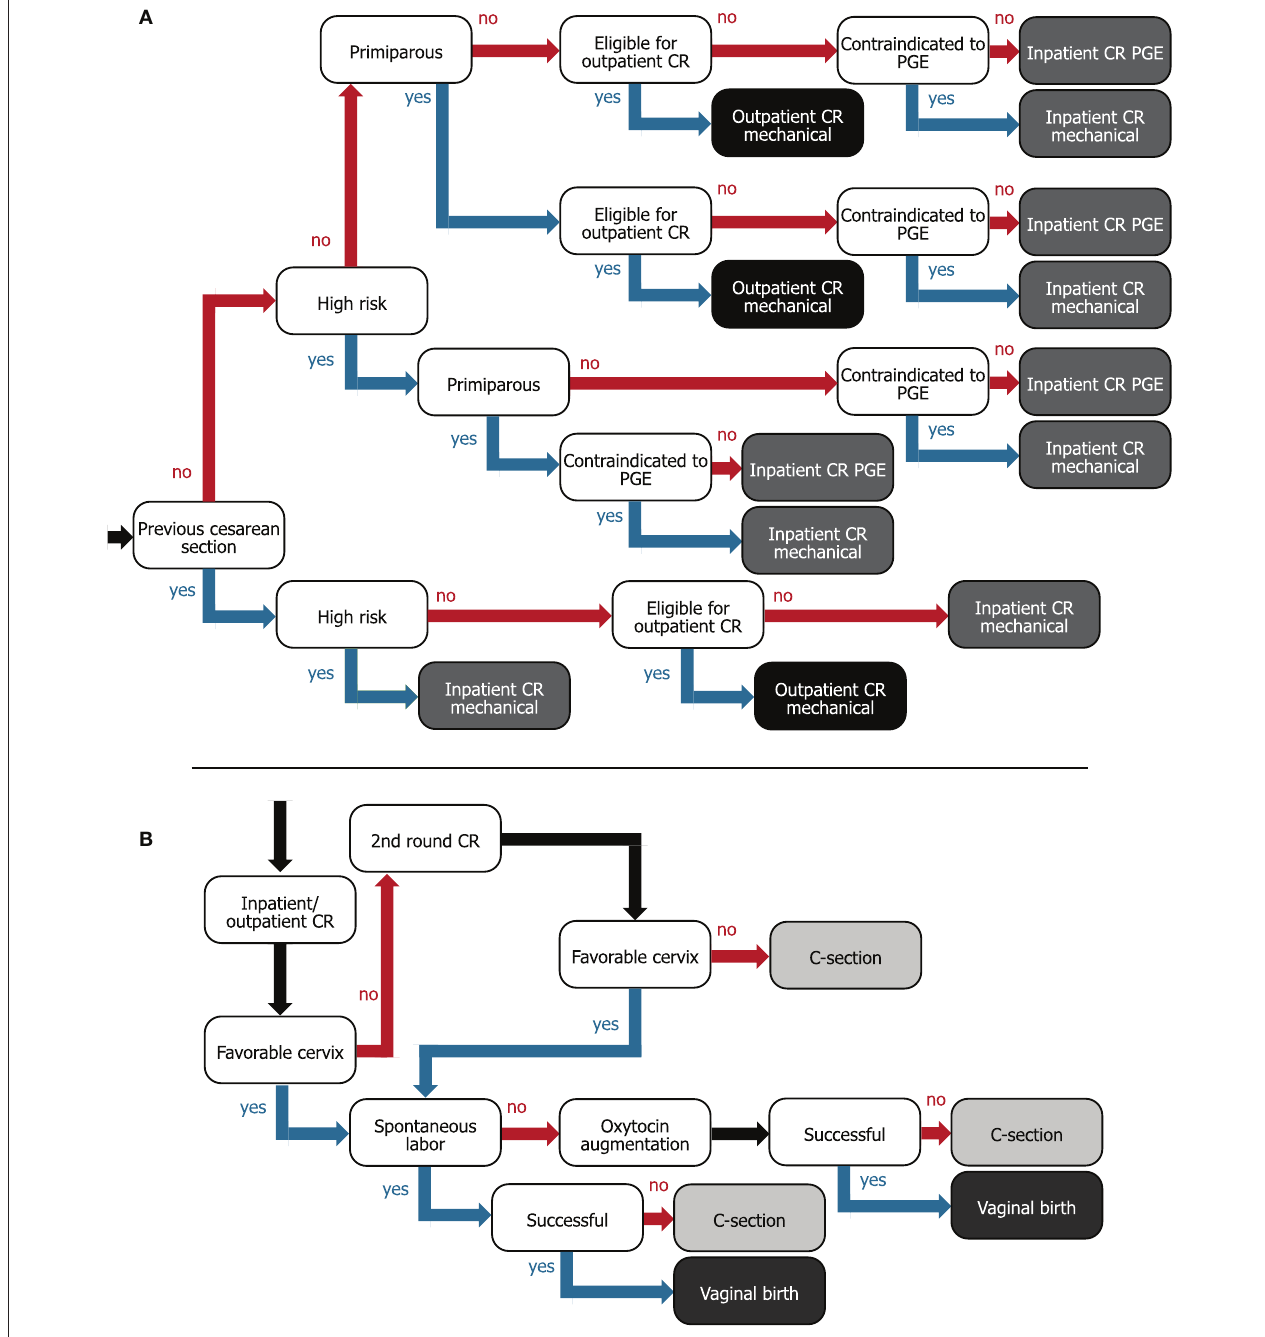
FIGURE 1 | Decision trees for (A) flow of women from hospital admission to assigning women to inpatient or outpatient for preinduction cervical ripening and (B) cervical ripening/IOL to delivery care pathway. For (A) , internal nodes (white boxes) describe patient characteristics and leaves (gray/black boxes) represent the type of ripening agent administered and whether women are ripened in the inpatient (gray) or outpatient (black) setting. (B) The internal nodes (white boxes) represent events or interventions, and the leaves (gray boxes) represent vaginal (dark gray) or cesarean birth (light gray) as the two possible outcomes. CR, cervical ripening; C-section, cesarean section; PGE,